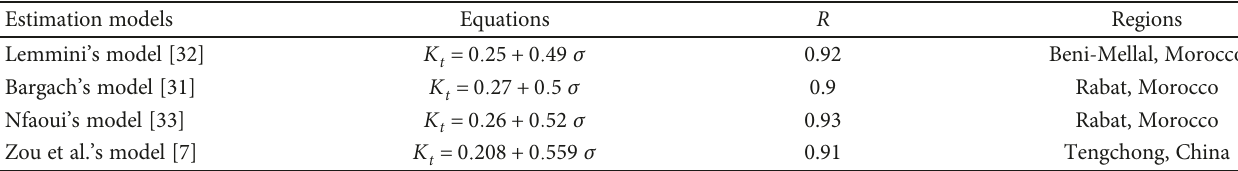
Table 1: Linear models for estimating daily global solar radiation.